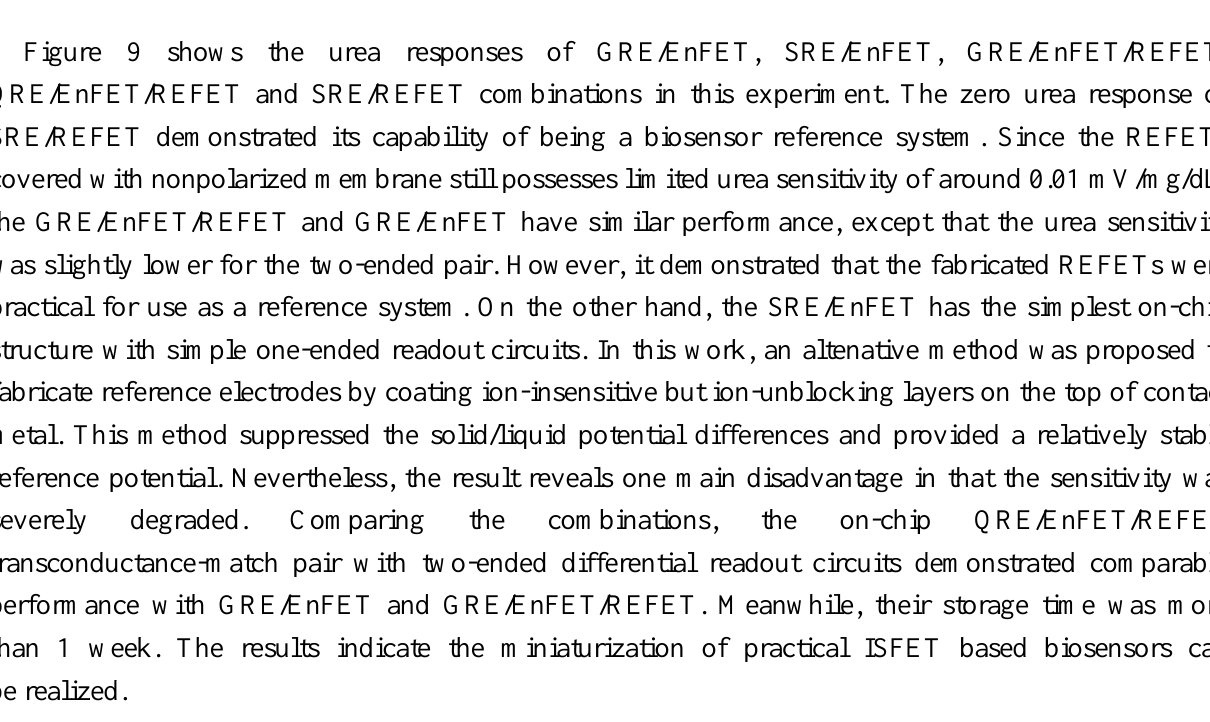
Figure shows the urea responses of GRE/EnFET, SRE/EnFET, GRE/EnFET/REFET,